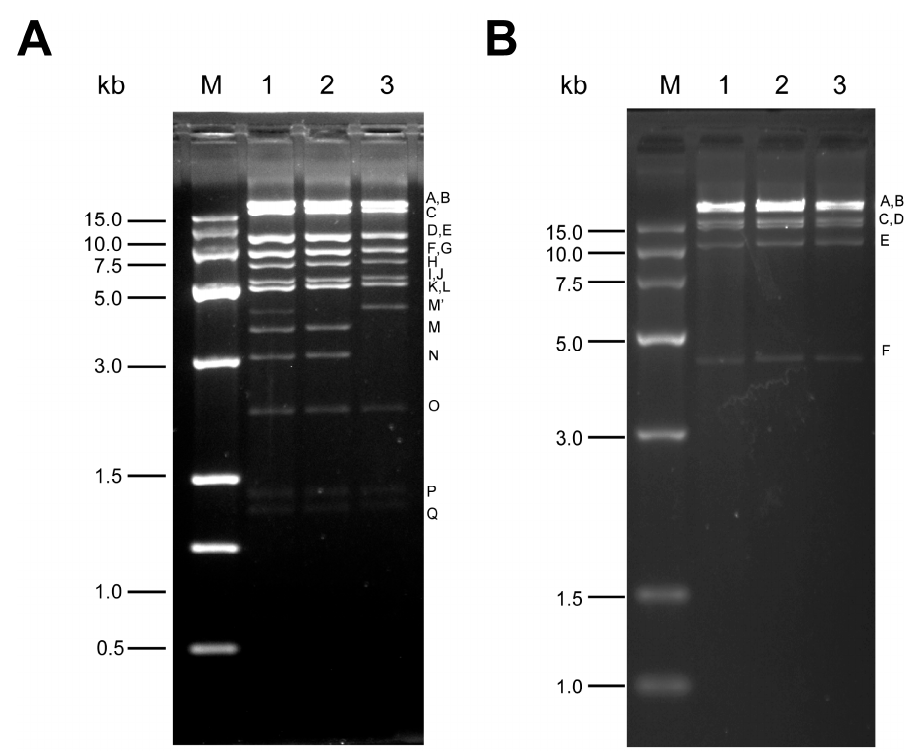
Figure 2. Restriction endonuclease (REN) profiles of a SfMNPV field isolate and genotypes digested with PstI ( A ) and BamHI ( B ), generated by electrophoresis on a 1% agarose gel. Lane 1: SfMNPV-Hub, Lane 2: SfMNPV-Hub (SfHub)-A, Lane 3: SfHub-E. All DNA segments were marked with a letter corresponding to their sizes. M: DNA marker, with the size of each segment was shown on the left.